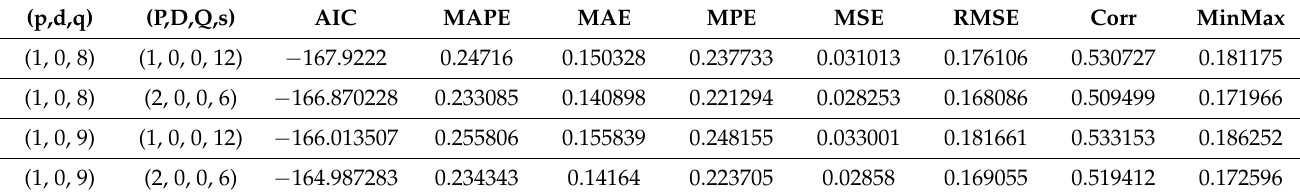
Table 2. Experimental results for SARIMA models Using Saudi Arabia dataset.